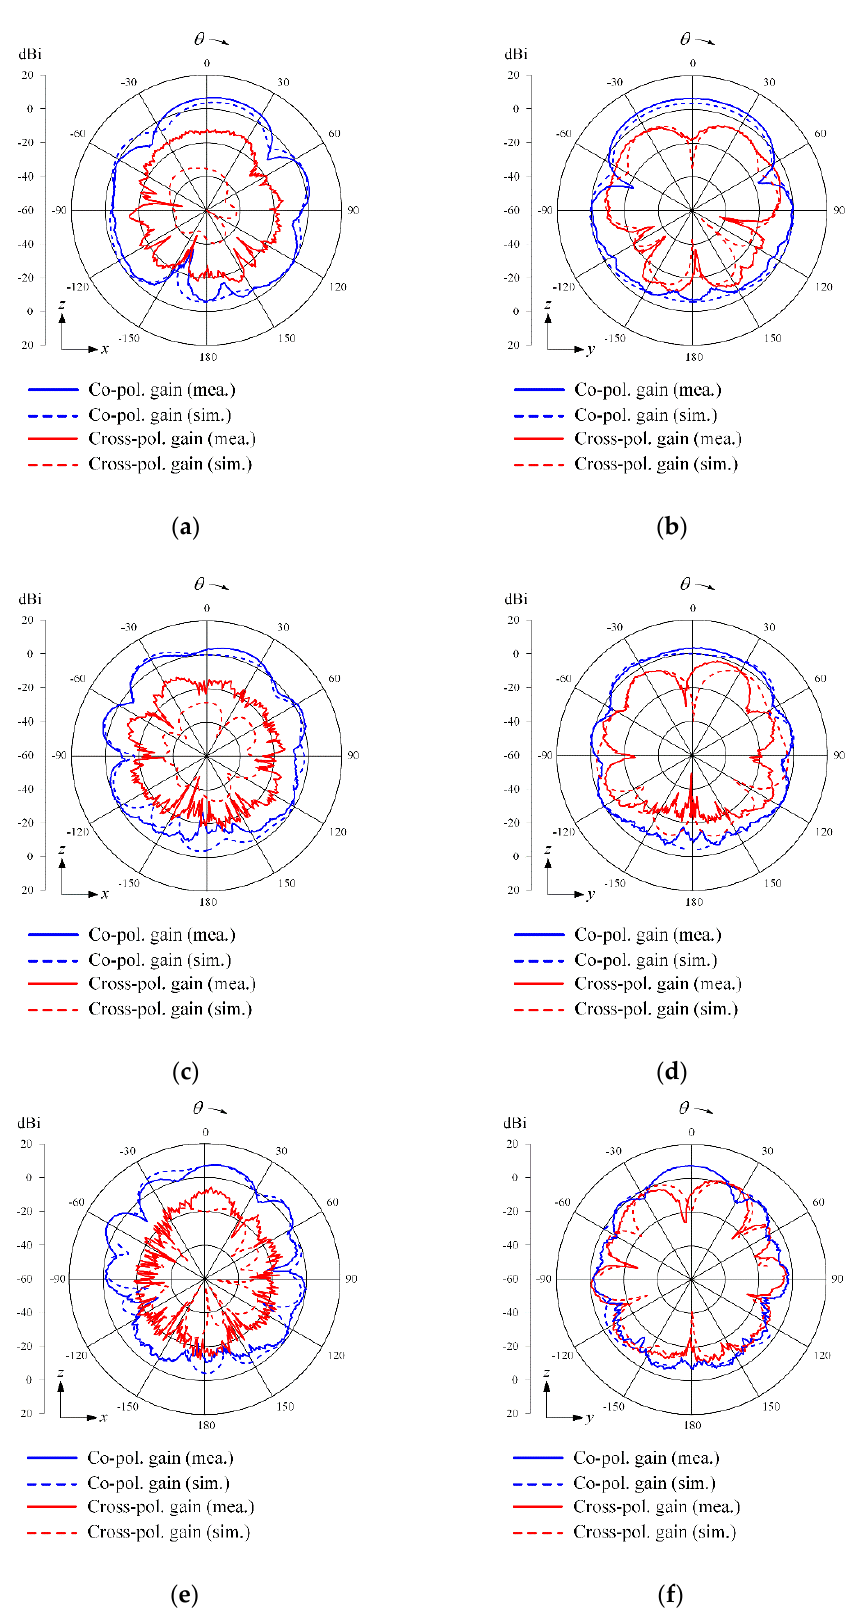
Figure 6. 2D radiation patterns: ( a ) zx -plane at 3 GHz; ( b ) zy -plane at 3 GHz; ( c ) zx -plane at 4.5 GHz; ( d ) zy -plane at 4.5 GHz; ( e ) zx -plane at 6 GHz; ( f ) zy -plane at 6 GHz.